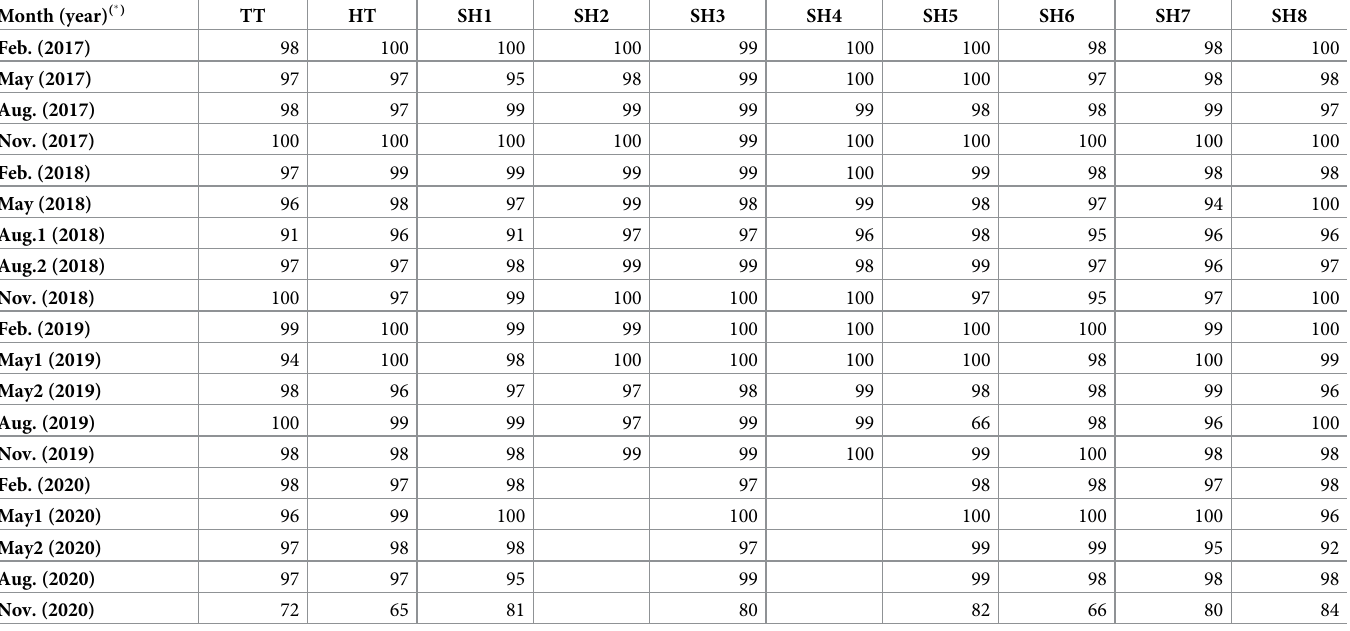
Table 5. The river WQI values for the ten sampling stations in the years